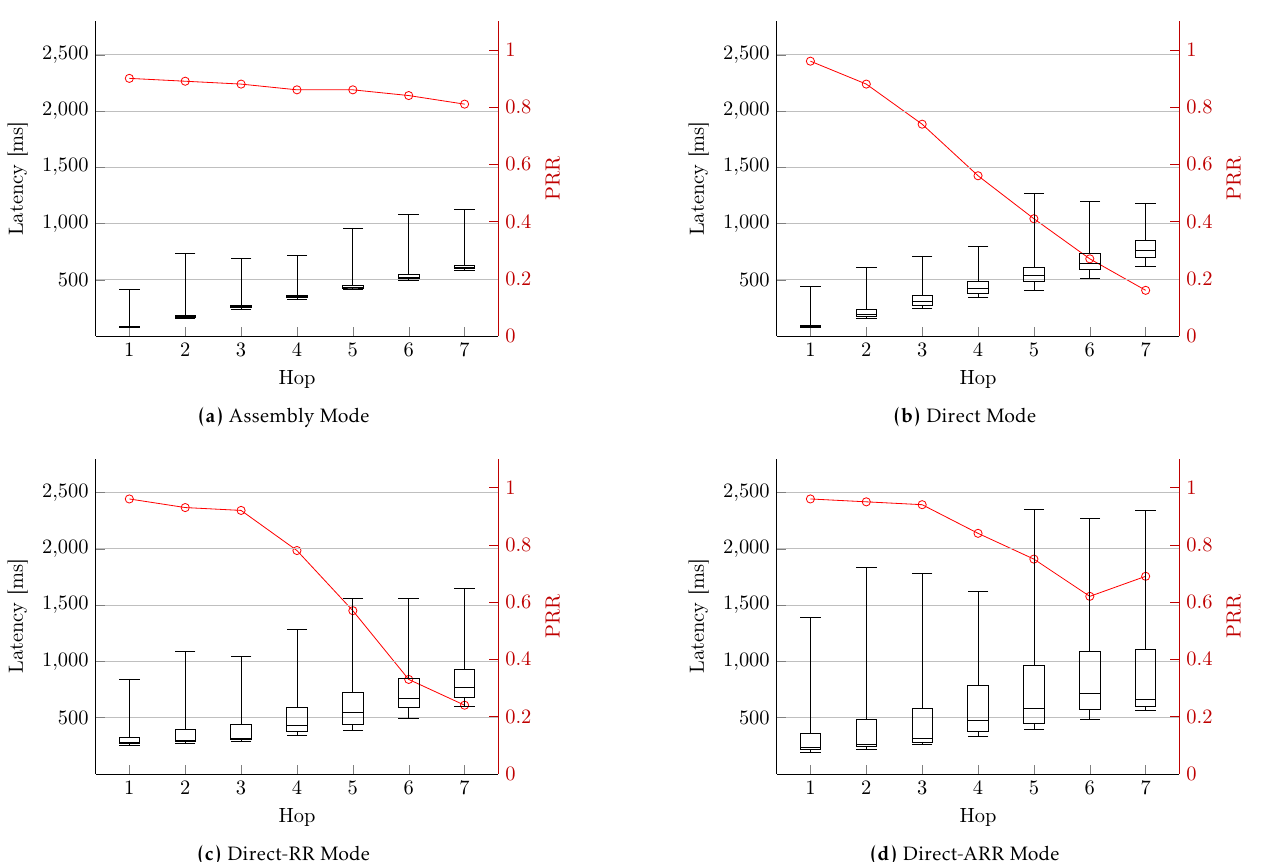
Figure 8. Per hop latency and PRR in the RealSim Network with 37 . 5 B/s and 1200 Byte payload; first set of experiments could not benefit from pipelining and exhibit latencies not significantly better than the Assembly